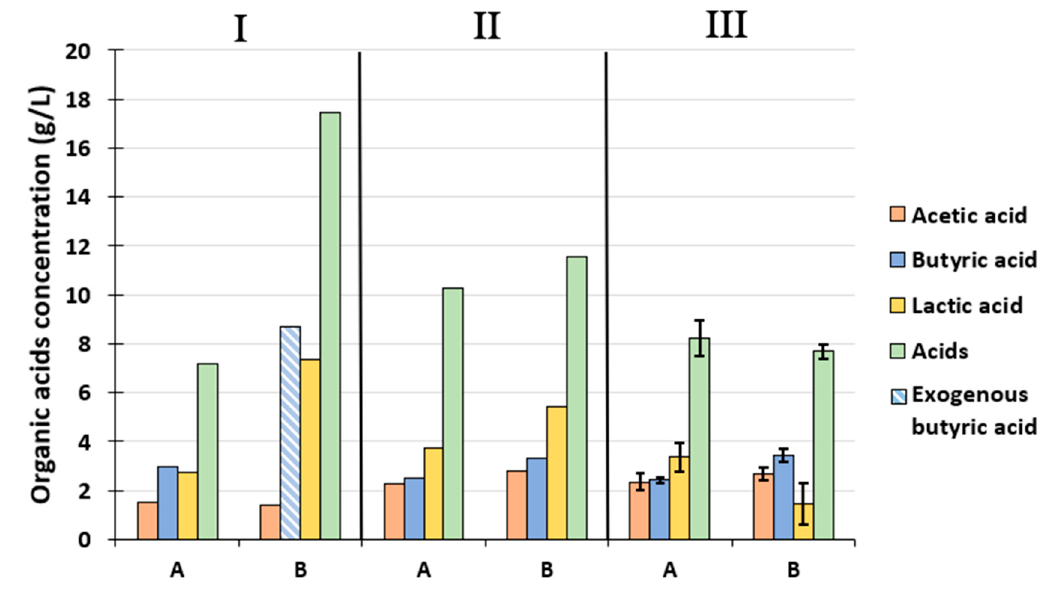
Figure 3. Endogenous organic acids concentrations in A and B conditions and exogenous butyric acid concentration in condition B, during the periods I at day 2, II at day 5, and III (average of three samples taken during the steady-date period) of the